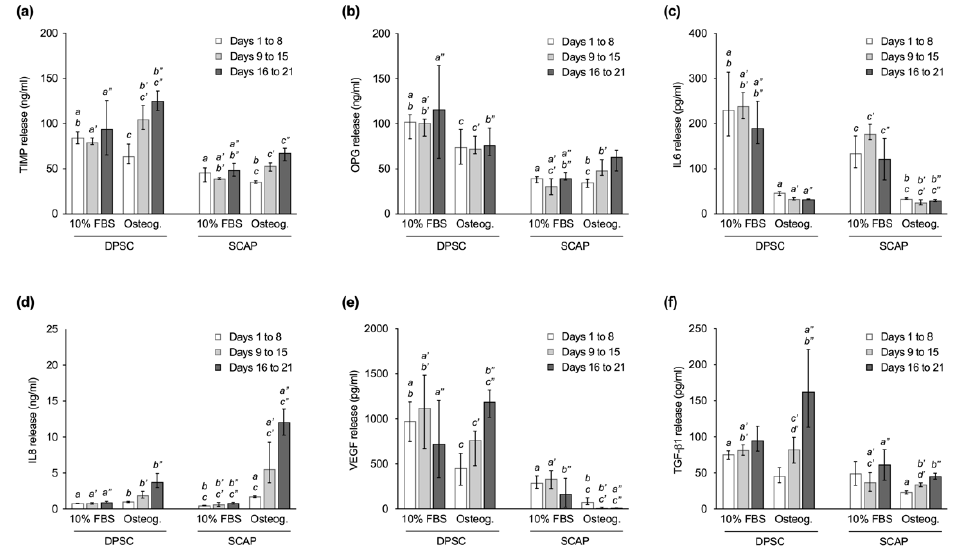
Figure 3. Release of signaling molecules by dental pulp stem cells (DPSC) and stem cells from the apical papilla (SCAP) in the initial phase (days 1 to 8), intermediate phase (days 9 to 15), and late phase (days 16 to 21) of culture. Graphs show the secretion of ( a ) tissue inhibitor of metalloproteinase (TIMP), ( b ) osteoprotegerin (OPG), ( c ) interleukin 6 (IL-6), ( d ) interleukin 8 (IL-8), ( e ) vascular endothelial growth factor (VEGF), and ( f ) transforming growth factor beta 1 (TGF- β 1). Median values and 25–75% percentiles are based on three independent experiments performed in triplicates ( n = 9). For each culture phase, equal lower-case letters indicate pairs that were found significantly different ( p ≤ 0.05). One or two apostrophes were added for the intermediate or late phase for a better